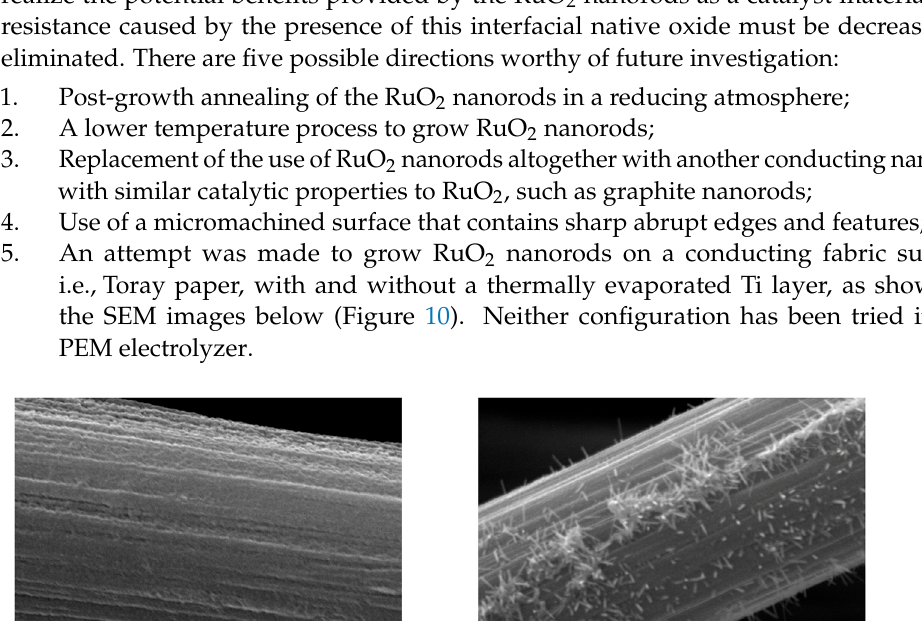
Figure 9. Square well quantum model for H atom in OER at the anode: ( a ) in equilibrium; ( b ) in the presence of a high electric field.